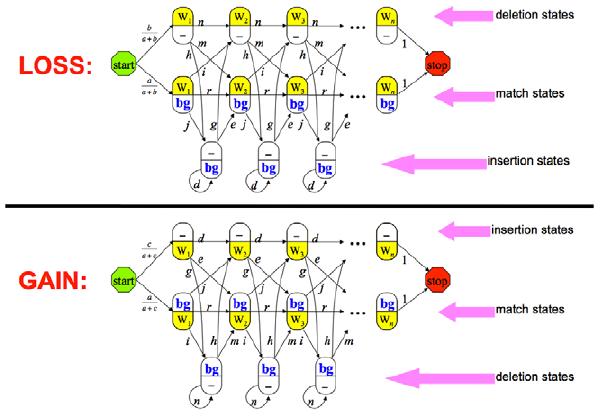
Figure 2. PPHMMs for loss (top) and gain (bottom) of function in a binding site. Ovals are emitting states. The top half of an emitting state denotes the functional class in the parent, while the bottom half denotes the functional class in the child. Dash denotes a gap. bg denotes the background functional class. W i denotes the functional class corresponding to the i th column in a positional weight matrix (PWM). Transition probabilities are derived from the background indel model. Emission probabilities are derived via a substitution mixture model.